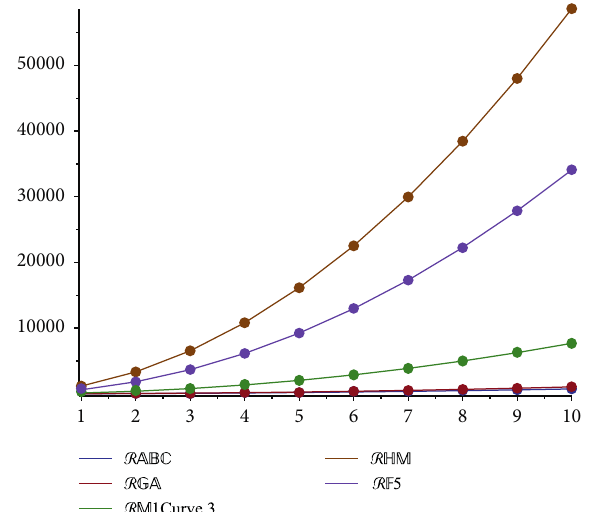
Figure 4: Graphical representation of Table 1.